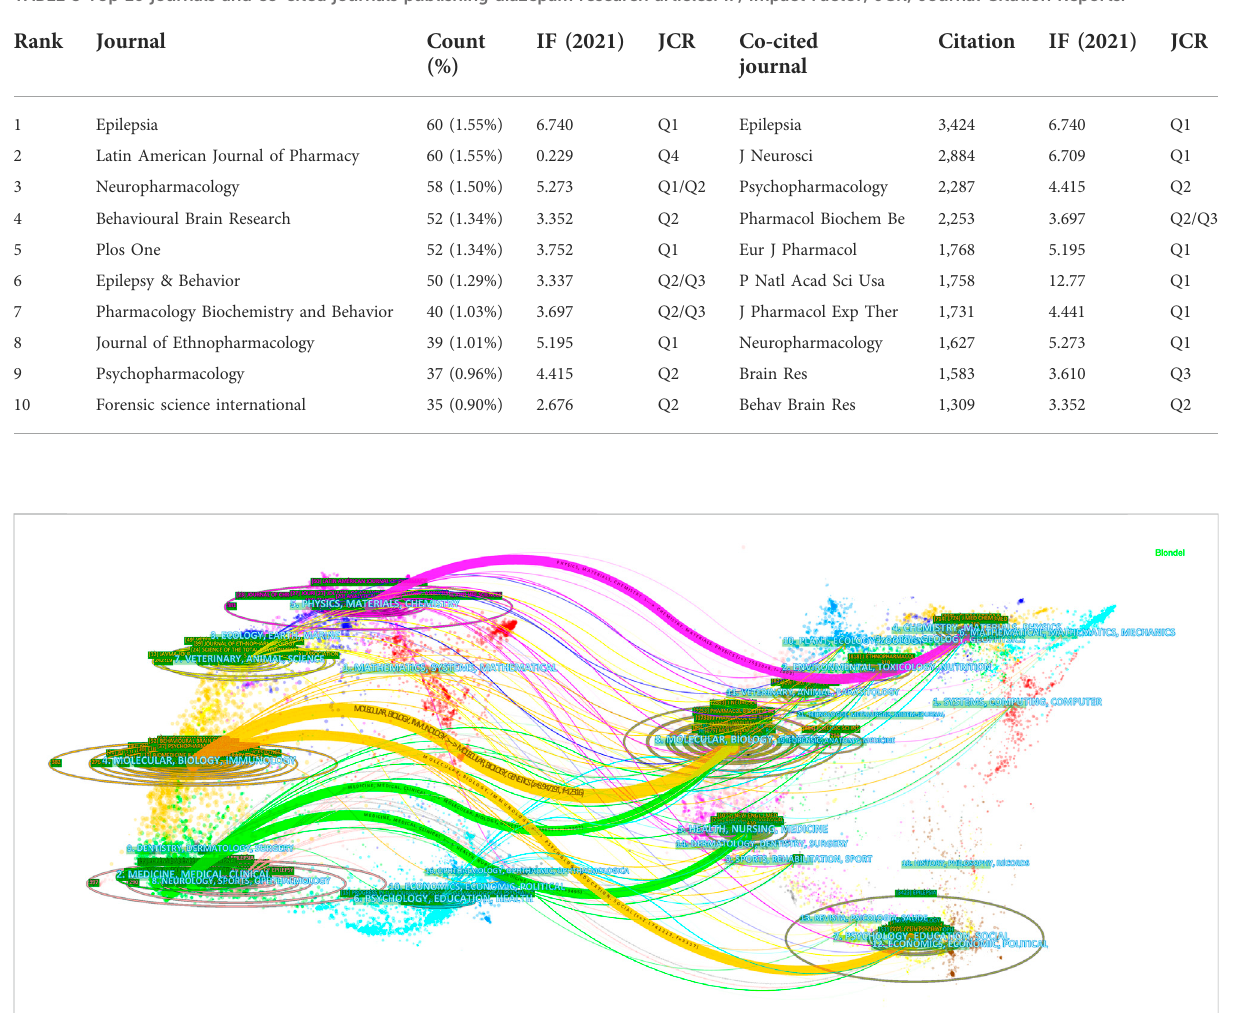
FIGURE 5 Dualmap overlay ofjournalswith diazepamcontent. Note: theciting journalsare ontheleft, andthecited journals areon theright.Color paths denote reference relationships, and thick lines denote main